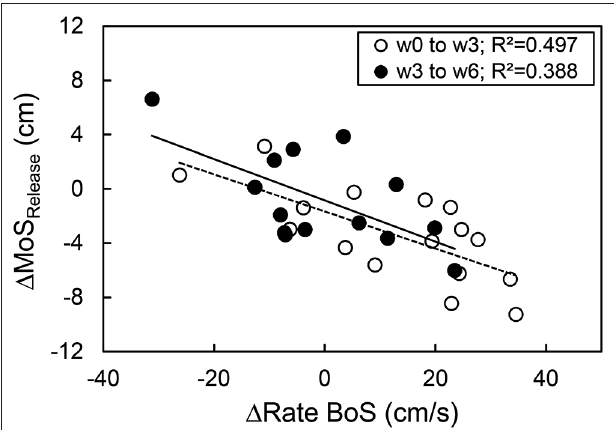
FIGURE 4 | Relationship between the exercise-induced change of the margin of stability at release ( 1 MoS Release ) and the rate of the base of support increase ( 1 Rate BoS) from release to touchdown during the simulated forward fall for the time course of week 0 to week 3 ( n = 16) and week 3 to week 6 ( n =